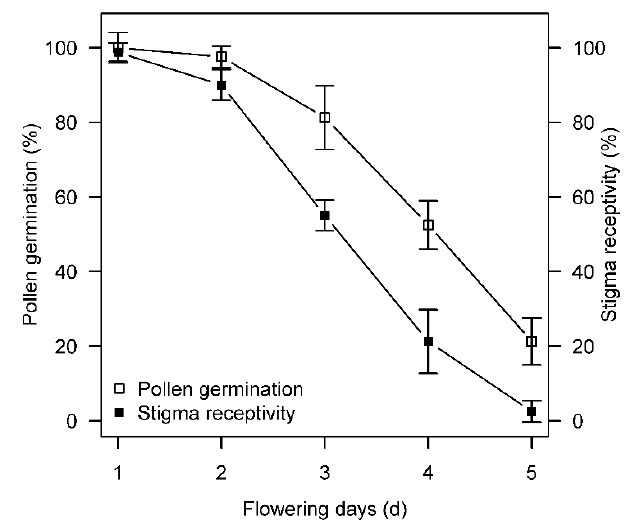
Figure 2. Variations in pollen germination rate and stigma receptivity with flower age in S. × hainanensis.